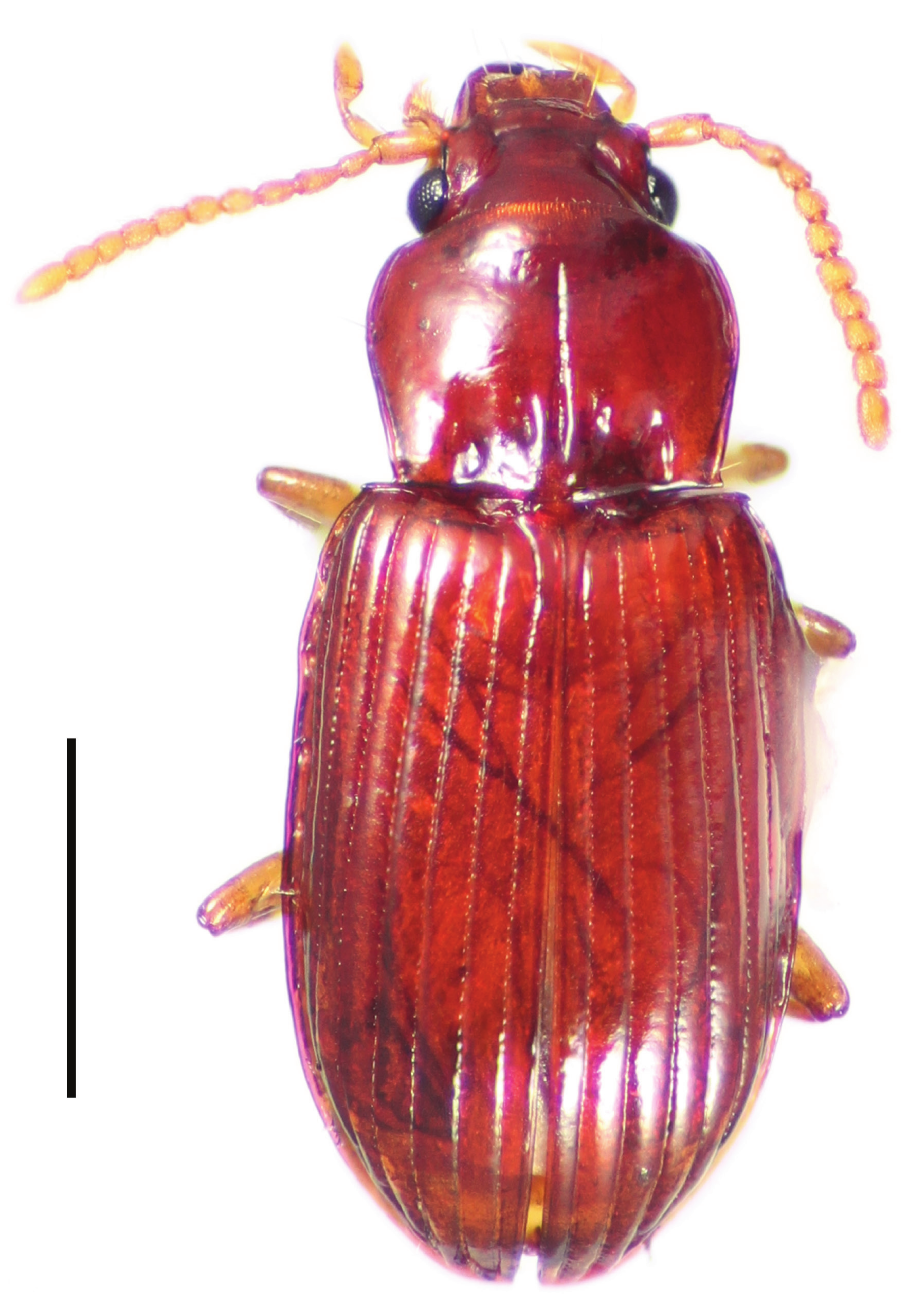
Figure 8. Dorsal habitus image of Cratocerus culpepperi Grzymala & Will, sp. n. Scale bar = 1.0